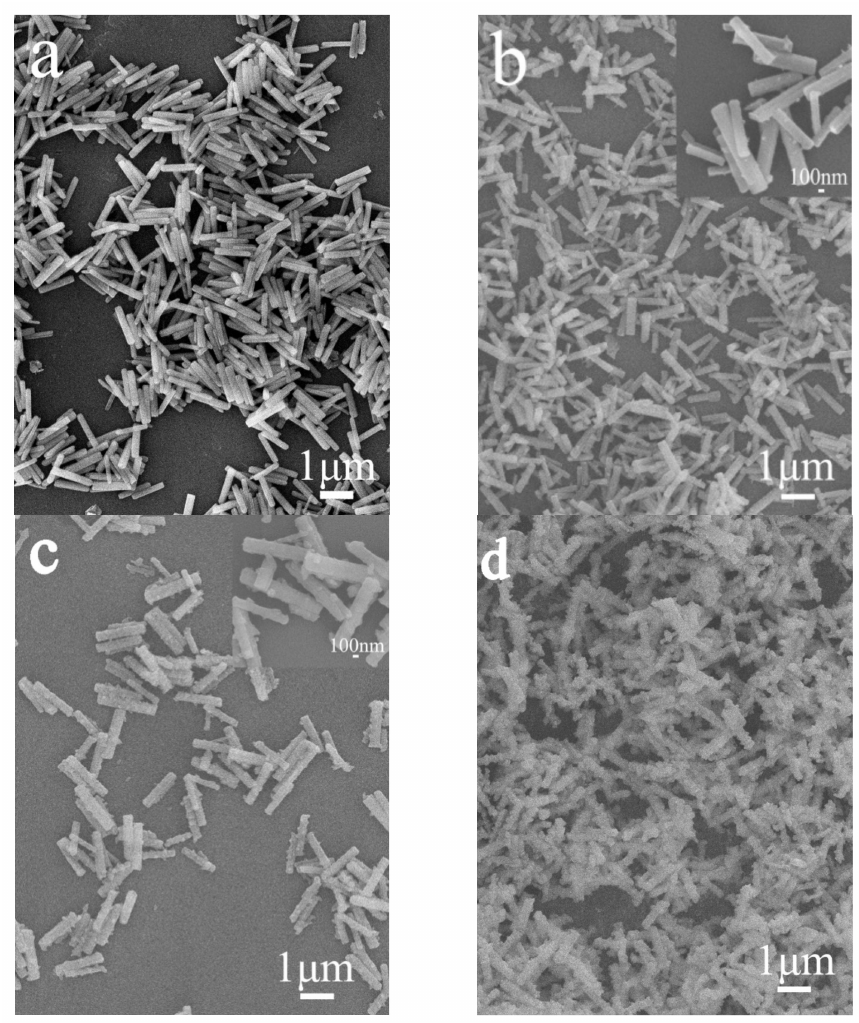
Figure 3. FE-SEM micrographs of MC ( a ) and MC- R M ( b – d ), with ( b ) R = 0.25, ( c ) R = 1.0, and ( d ) R